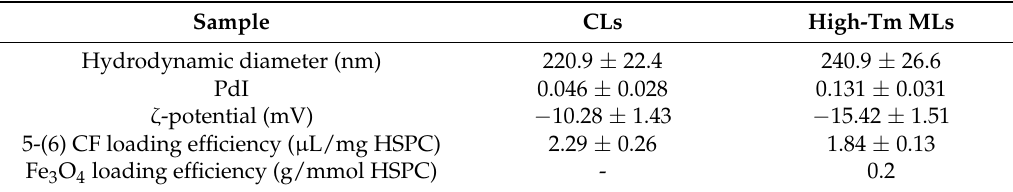
Table 1. Physical characterization of liposomes: the hydrodynamic diameter (Z-average), PdI values and ζ -potential values for control liposomes (CLs) and magnetic (high-Tm MLs) liposomal preparations were determined immediately after size exclusion chromatography (SEC) purification. Loading efficiency of 5-(6) CF and iron oxide are also